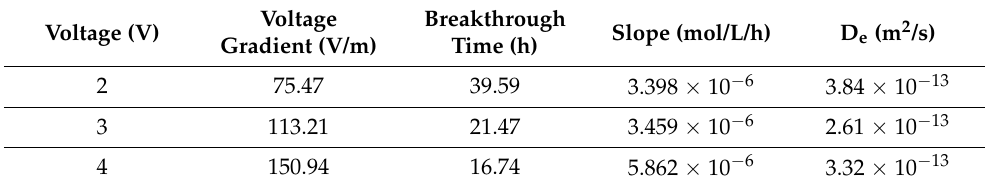
Table 3. Electromigration modeling results with ideal plug-flow modeling of Sr 2+ migrating through the rock